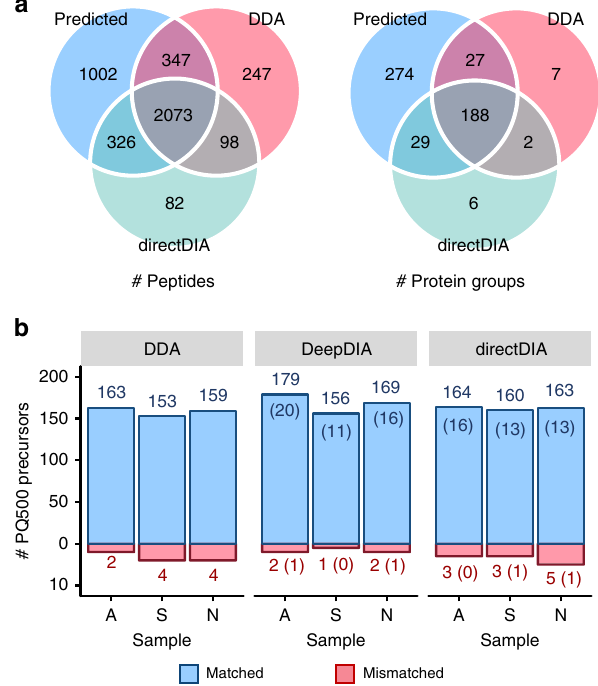
Fig. 5 DIA analysis results of a dataset of human serum. a The numbers of peptides and protein groups detected using the predicted library (PlasmaPredicted), the DDA-based library (SerumDDA), and directDIA. b Numbers of PQ500 precursors without isotope label detected in the three samples using the DDA-base library (SerumDDA), the DeepDIA predicted library (PlasmaPredicted) and directDIA. Numbers in parentheses indicate the numbers of PQ500 precursors absent in the result using the DDA- based library. A, S, and N represent the three serum samples, respectively. Details of the spectral libraries are described in Supplementary Table